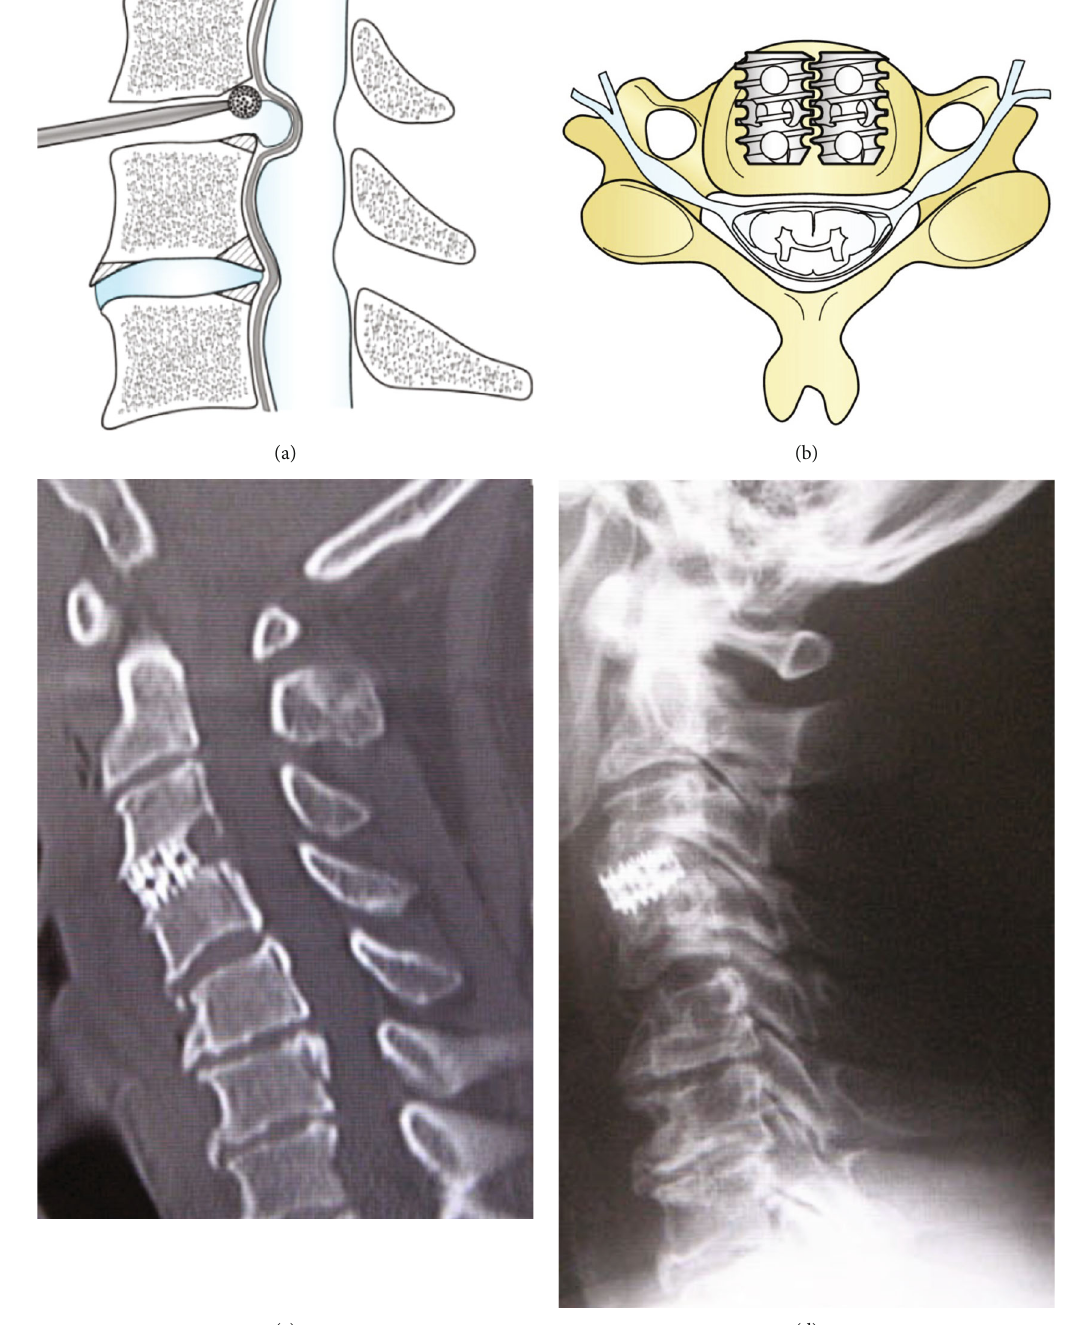
Figure 2: Schematic drawings in the sagittal view of anterior cervical discectomy and fusion (ACDF) and postoperative CT. Osteophytes after discectomy are drilled out by a diamond burr (a). Cages are inserted into the disc spaces in the twin-cage and locking fashion after decompression. Postoperative (c) CT and (d) X-ray show su ffi cient decompression, and the cage was inserted in the optimal